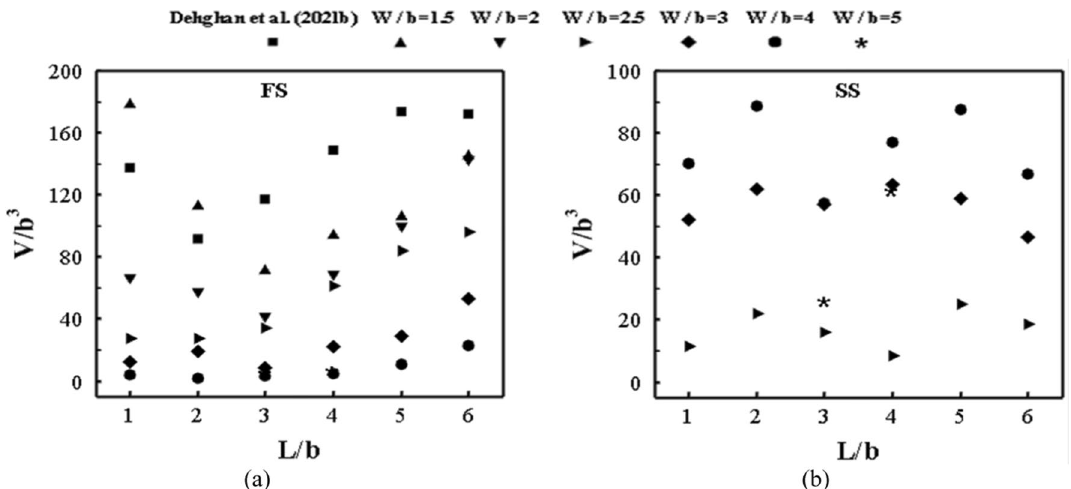
Fig. 3 Values of the volume of scouring cavities created surrounding the rectangular piers and collars combination